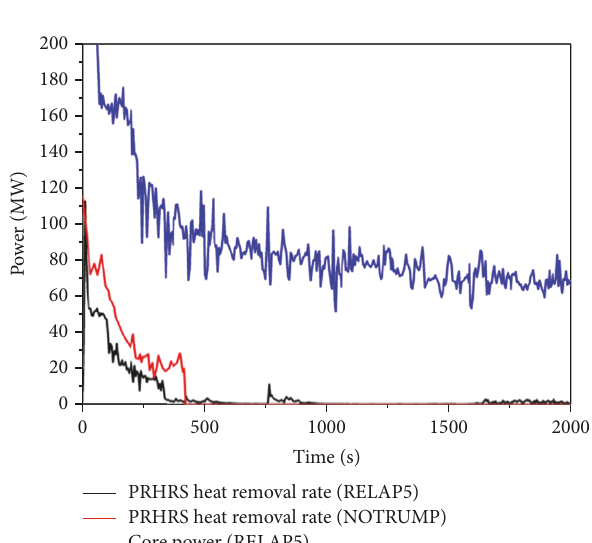
Figure 14: PRHRS heat removal rate.